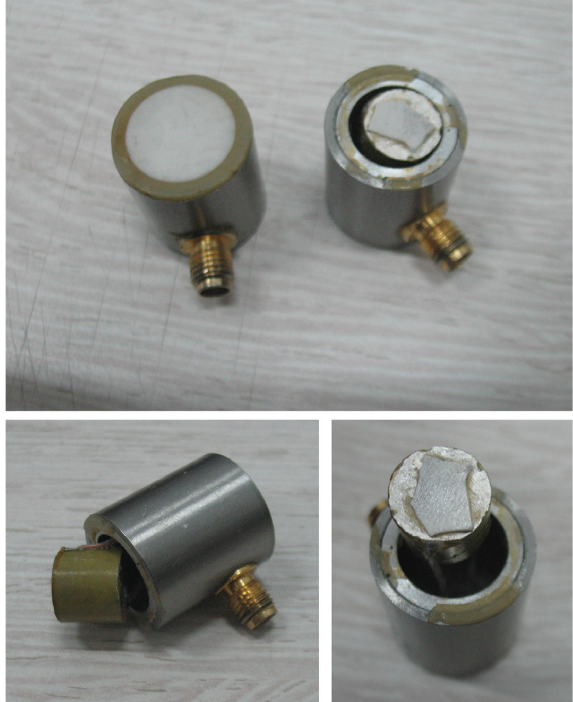
Figure 12: Damaged AE detector.